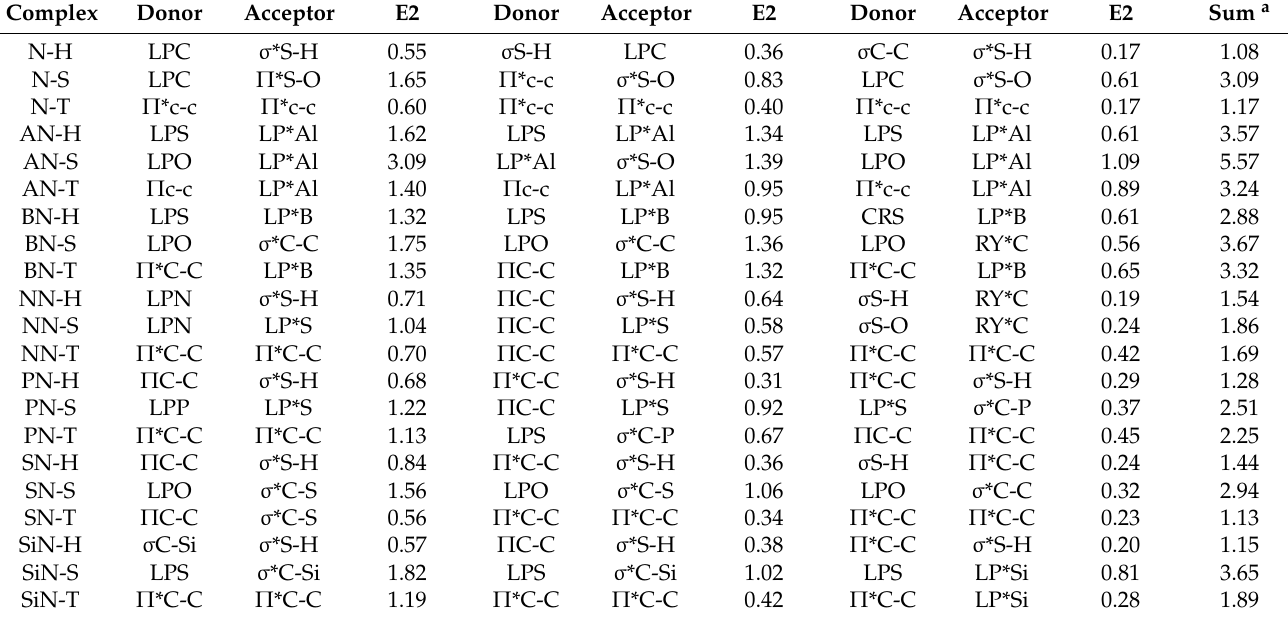
Table 4. The strongest second-order perturbation energies (E2) (in kcal/mol) for the donor-acceptor transaction for all